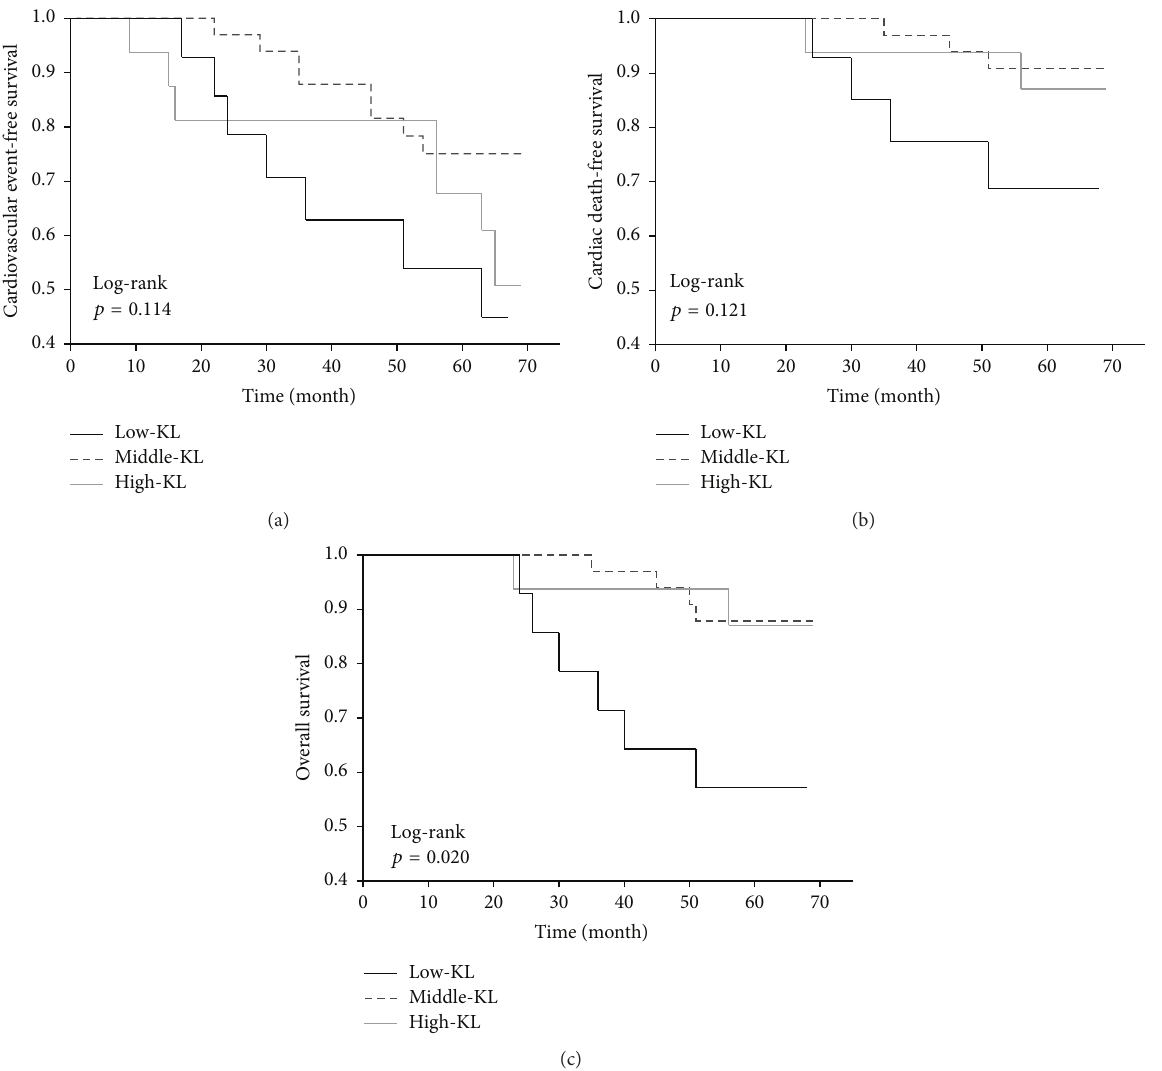
Figure 1: Kaplan-Meier plots of cardiovascular event-free survival (a), cardiovascular mortality (b), and cumulative survival (c). The patients were categorized into low-KL ( < 309 pg/mL), middle-KL (309 to < 449 pg/mL), and high-KL ( ≥ 449pg/mL)